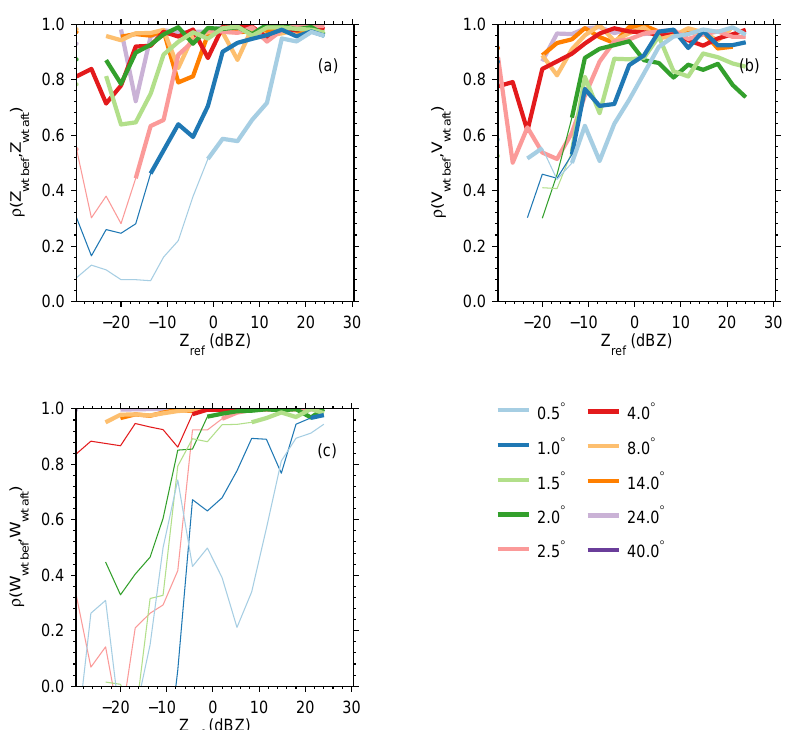
Figure 9. Correlation coefficients, ρ , between frequency distributions of spectral moments from a wind-turbine-affected radar cell before ( Z wt bef , V wt bef , and W wt bef ) and after ( Z wt aft , V wt aft , and W wt aft ) the construction of the Brunsmo wind farm, as a function of reflectivity from a reference radar cell, Z ref , for all tilt angles. The correlation of the spectral moments recovers for higher values of Z ref (increasing influence of the weather signal) and for higher tilt angles (decreasing influence of the wind farm). Correlations significant on the p < 0 . 05 level are drawn with thick